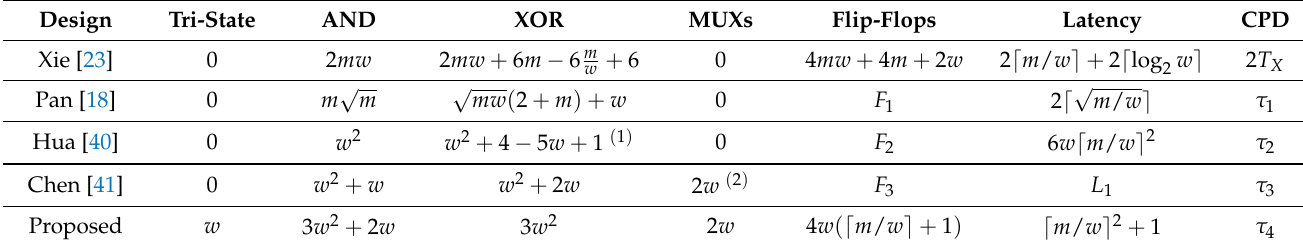
Table 1. Comparison between different word-serial field